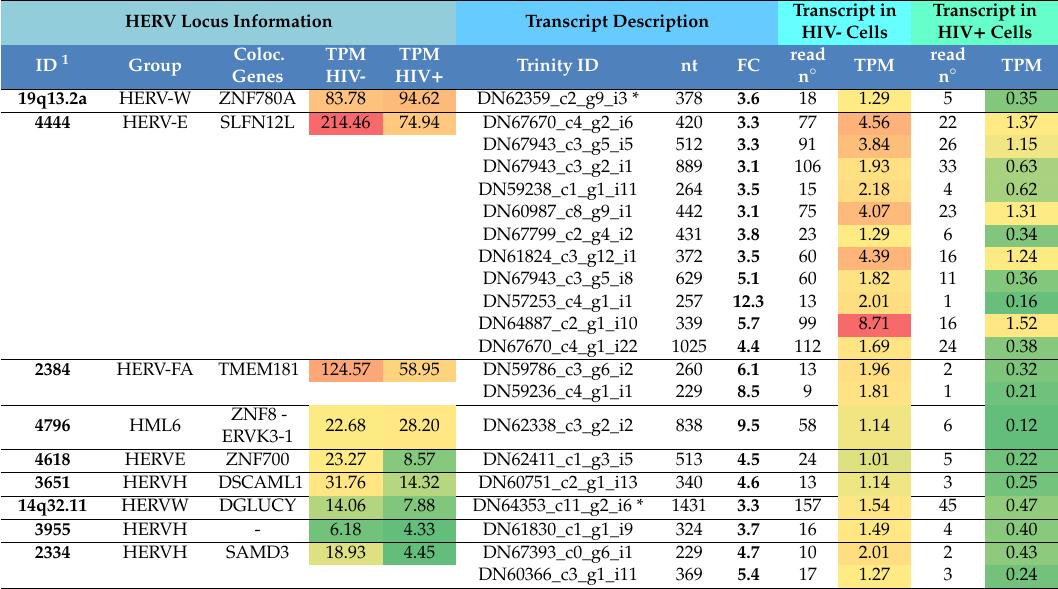
Table 2. HERV-derived transcripts modulated in the presence of HIV infection. HERV Locus Information Transcript Description